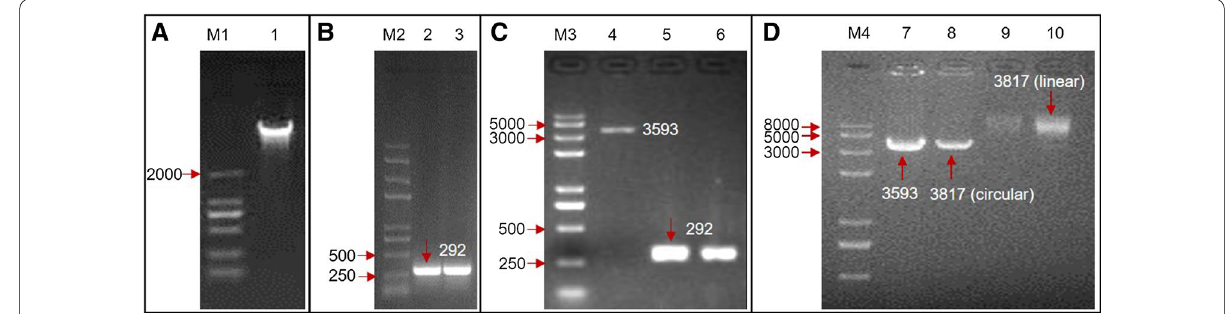
Fig. 2 Agarose gel electrophoretic analysis of DNA. In panel A Paenibacillus terrae NK3‑4 genomic DNA; in panel B esxA amplification; in panel C purified vector (lane 4) and esxA (lane 5 and 6) preparation; in panel D construction and linearization of pPICZαA‑ esxA. M: marker (M1: DL2000; M2, M3 and M4: D8000); lane 1: genomic DNA; lane 2, 3: amplified esxA ; lane 4: pPICZαA vector; lane 5, 6: amplified esxA product recovered from the agarose gel; lane 7: circular pPICZαA; lane 8: circular pPICZαA‑ esxA ; lane 9, 10: linear pPICZαA‑ esxA ; DNA lanes labled with molaculor weight